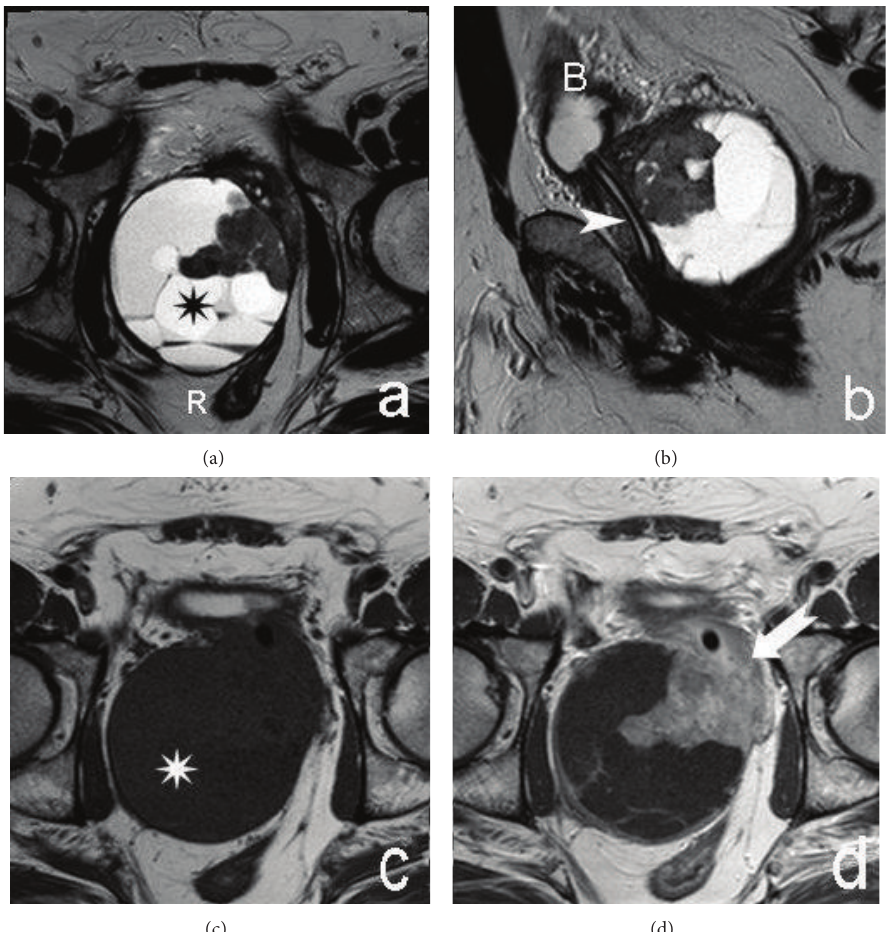
Figure 3: MRI. Axial (a) and sagittal (b) T2-weighted images. Axial precontrast (c) and postcontrast (d) T1-weighted images. The asterisk is on the cystic component of the prostatic lesion; septa are evident. The arrow shows the solid component that improves after Gadolinium injection. Note the presence of a urinary catheter (arrowhead). B = bladder; R =